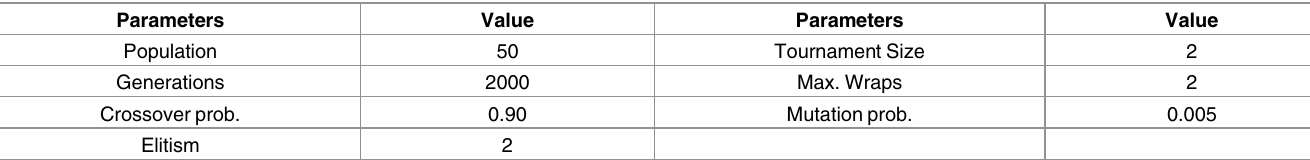
Table 1. General parameters of the implementation of GE and its